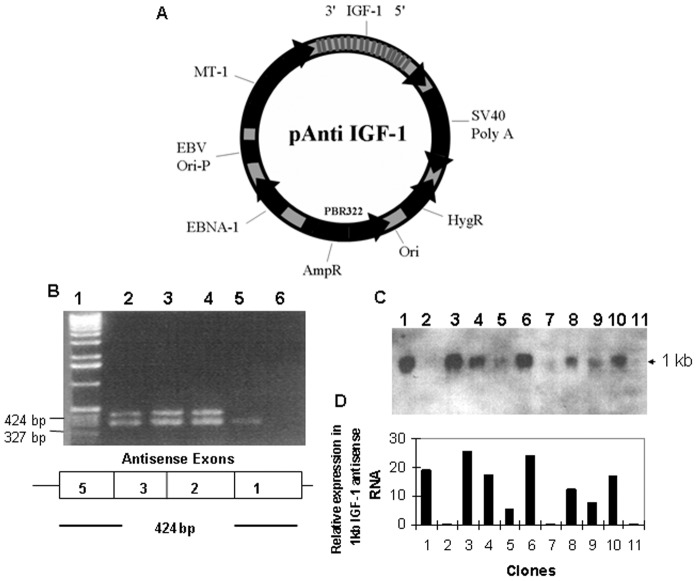
Transfection of HGB cells with the vector pAnti IGF-1.
A, Physical map of pAnti IGF-1. MT-1: metallothionein - 1 promotor; IGF-1 3′-5′: human IGF-1 DNA sequence in antisense orientation; SV40 poly A: SV40 poly A termination sequence; Ori: origin of replication; Hyg R: hygromycin resistance gene; Amp R: Ampicillin resistance gene; EBNA-1: Epstein Barr Virus (EBV) encoded nuclear antigen 1; EBV ori-P: EBV origin of replication. B, Expression of IGF-1 cDNA in transfected HGB cells. Primer pairs for RT-PCR used to detect and amplify antisense IGF-1 cDNA are as designated in methods. This set of primers gives rise to a 424 bp cDNA band containing exons 1, 2, 3 and 5 of the IGF-1 molecule in antisense orientation. Lane 1 shows the molecular weight markers of ØX174 DNA cut by HaeIII. Lanes 2, 3 and 4 demonstrate the 424 bp band, and a 327 bp β-actin band (internal control). Lane 5 shows a negative clone, which did not express IGF-I antisense cDNA. Lane 6 depicts a negative control in which all constituents of the reaction were present but not the DNA template. C, Detection of IGF-1 antisense RNA transcripts in HGB cells by Northern blot analysis. 30ug of total RNA from non-Transfected and transfected clones of HGB cells were applied to 1.0% formaldehyde agarose gel. 32P-labeled IGF-I cDNA was used as probe. Lanes 1, 3, 4, 5, 6, 8, 9 and 10 demonstrate the dominant 1 kb IGF-1 antisense RNA band from each of 8 separately transfected clones. Lanes 2, 7 and 11 represent RNA of non-transfected clones.
Fig 1

C represents result for one set of the experiments;
Fig 1

D represents the semi-quantitative densitometry analysis for C as determined by the NIH image J program.